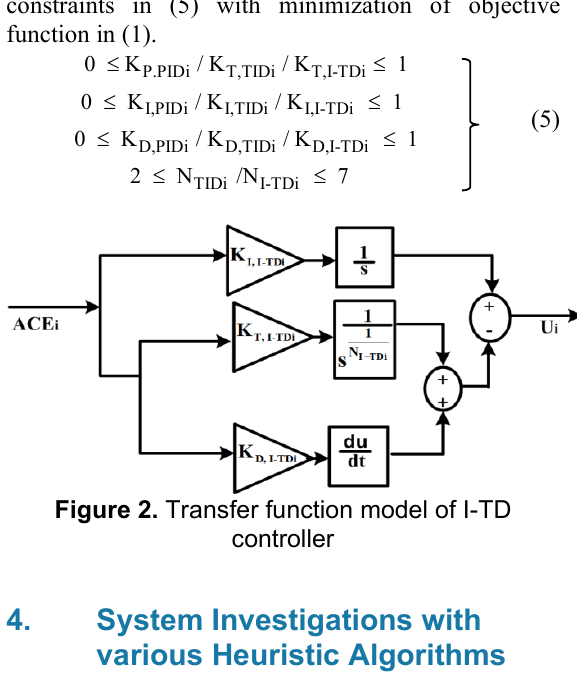
Figure 2. Transfer function model of